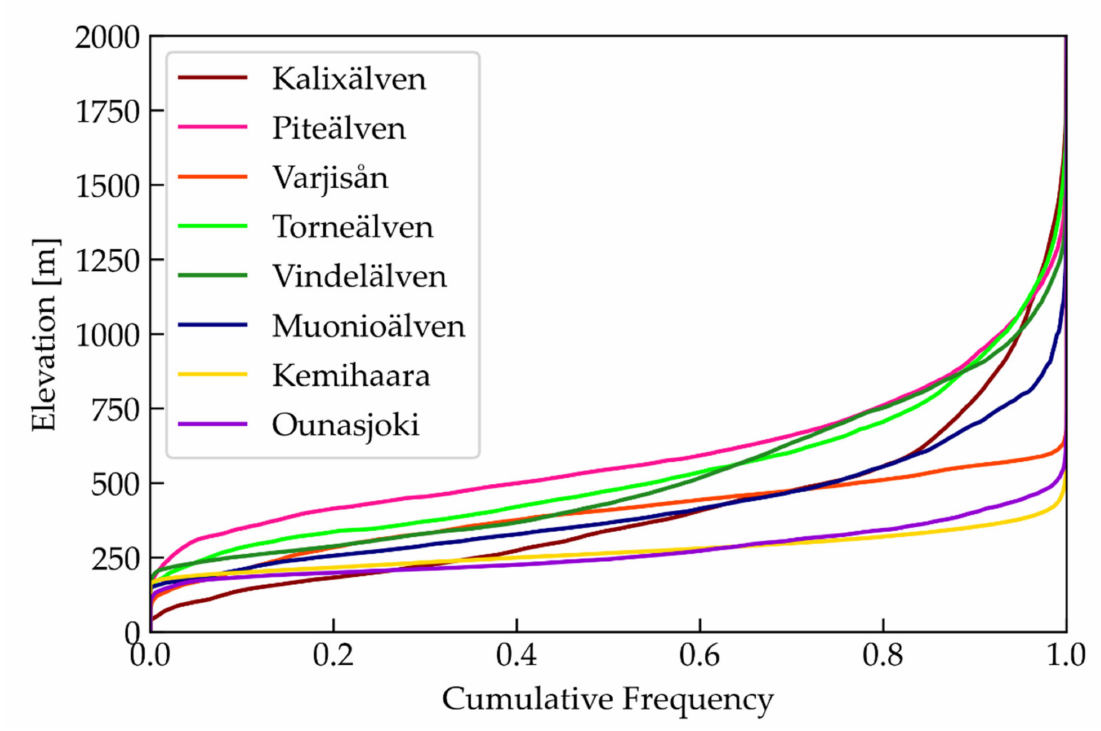
Figure 3. Hypsometric curves of the eight selected